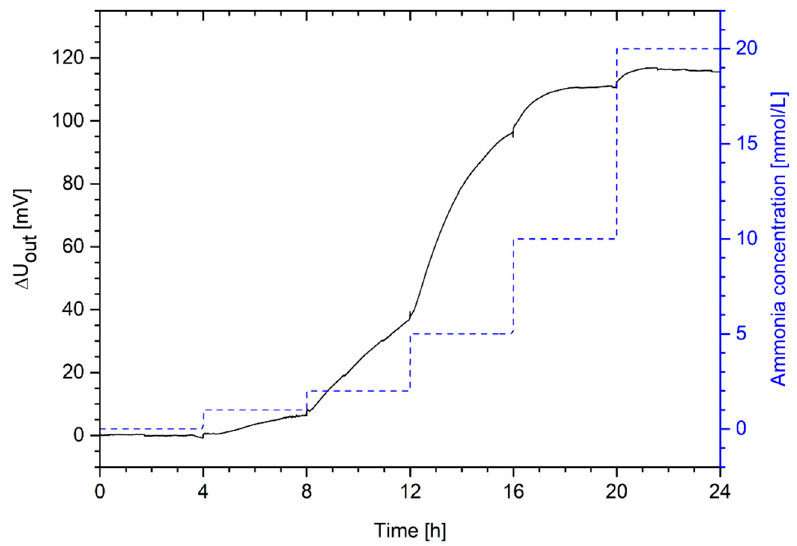
Figure 8. Change in output voltage of a piezoresistive ammonia sensor based on poly(AAc- co - DMAEMA) (60 mol% AAc, 40 mol% DMAEMA) hydrogels in a range from 0 mmol/L to 20 mmol/L ammonia in PBS buffer.